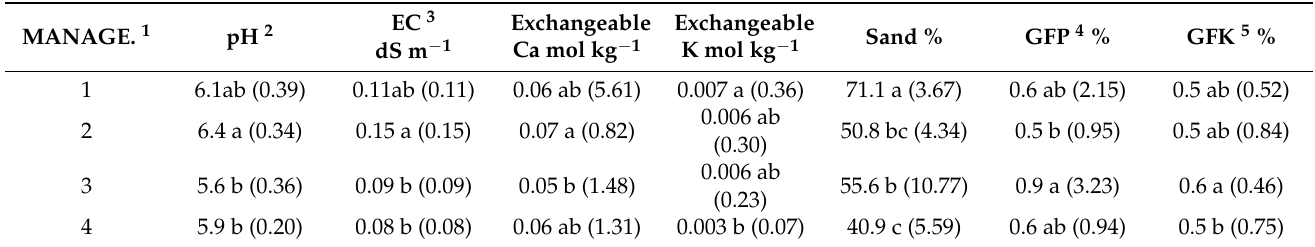
Table 4. Mean values of the soil properties and foliar nutrient contents with significant differences according to meadow